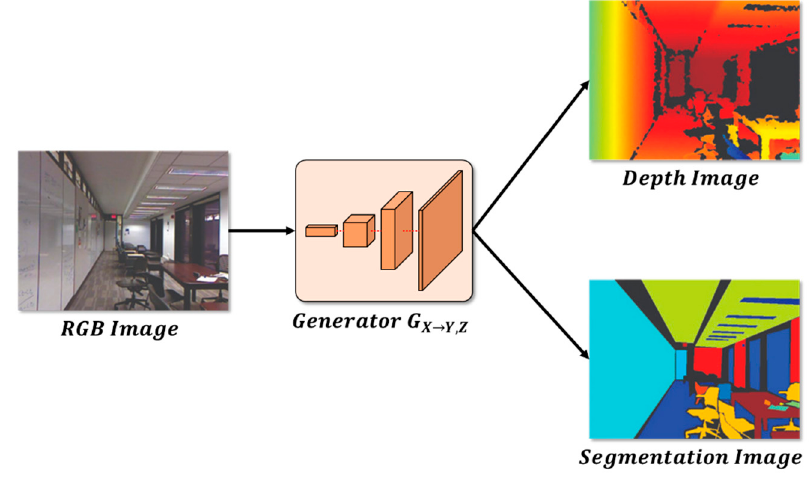
Figure 12. Network structure for estimating depth and segmentation information.